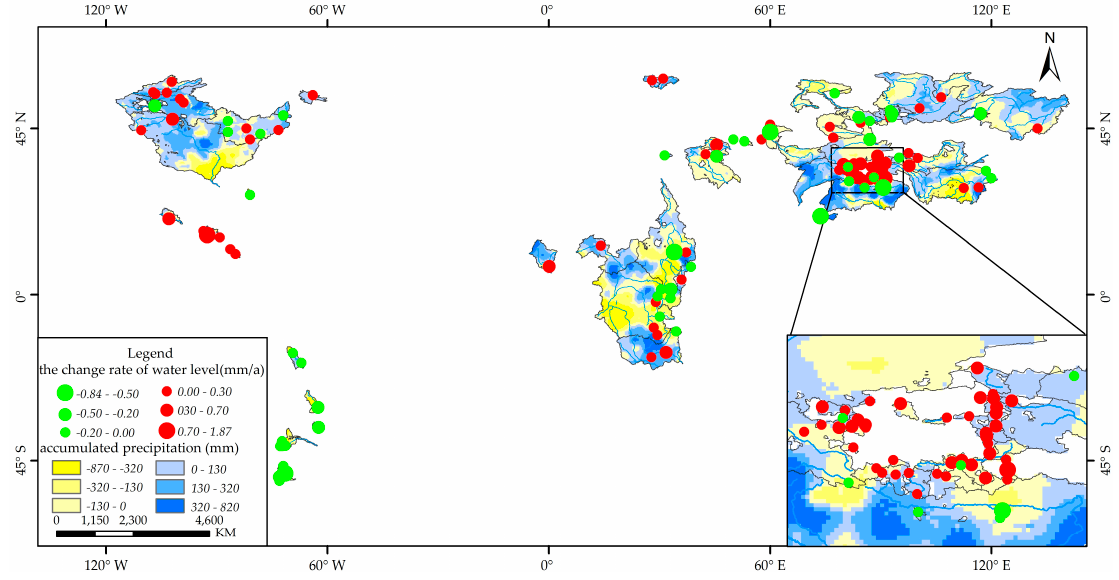
Figure 4. Accumulated precipitation and trend changes of the lake level in the watershed data.